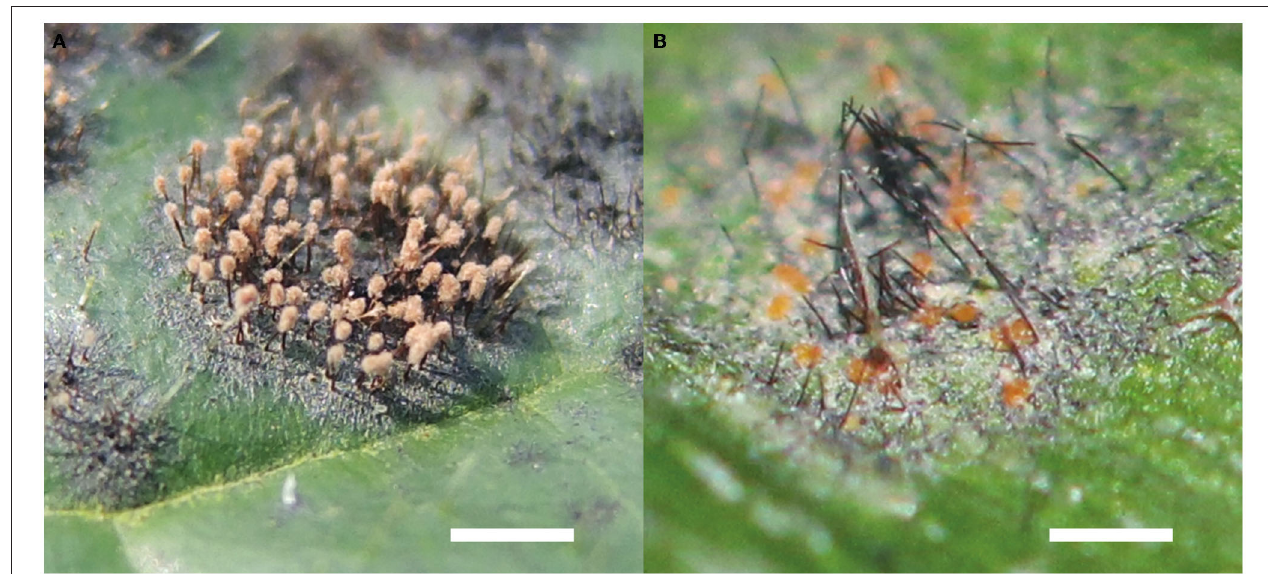
FIGURE 4 | Hyperparasitic fungi of Meliolales. (A) Synnemata of Atractilina parasitica growing on Meliola clerodendricola , on a leaf of Clerodendrum capitatum . Bar, 1 mm. (B) Orange perithecia of Dimerosporiella cephalosporii on black superficial hyphae among setae of Meliola sp., on a leaf of Olyra latifolia . Bar, 1 mm.